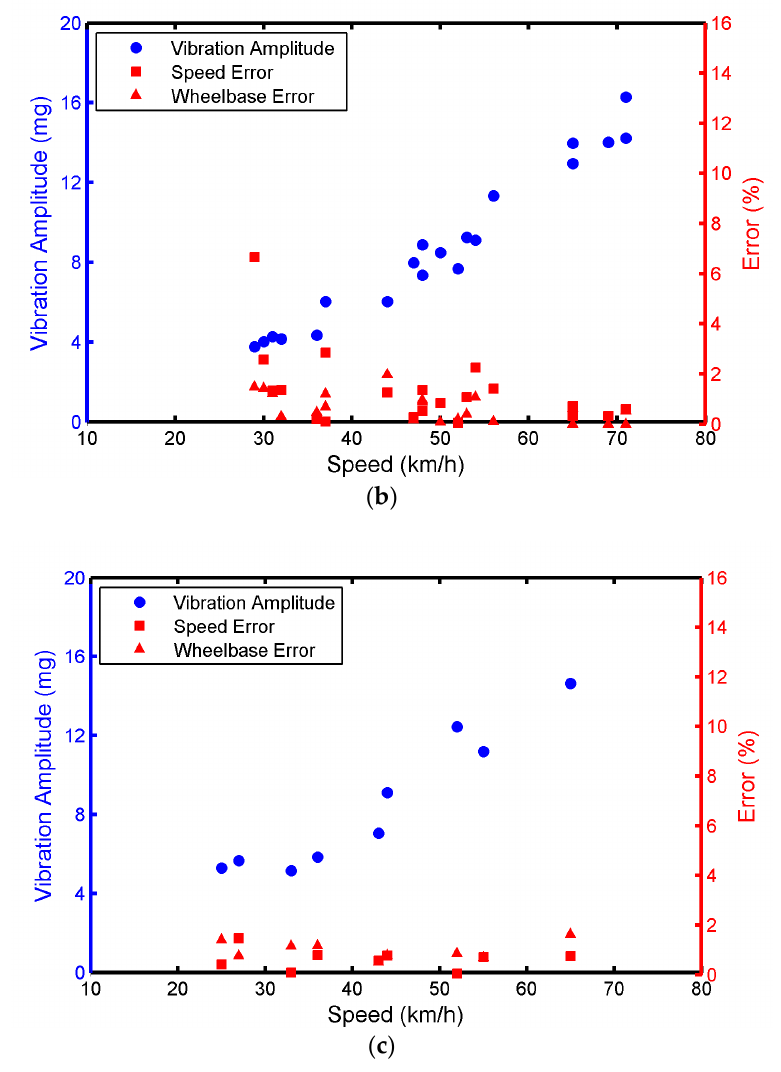
Figure 13. The effect of vehicle speed on the vibration amplitude, speed error, and wheelbase error.